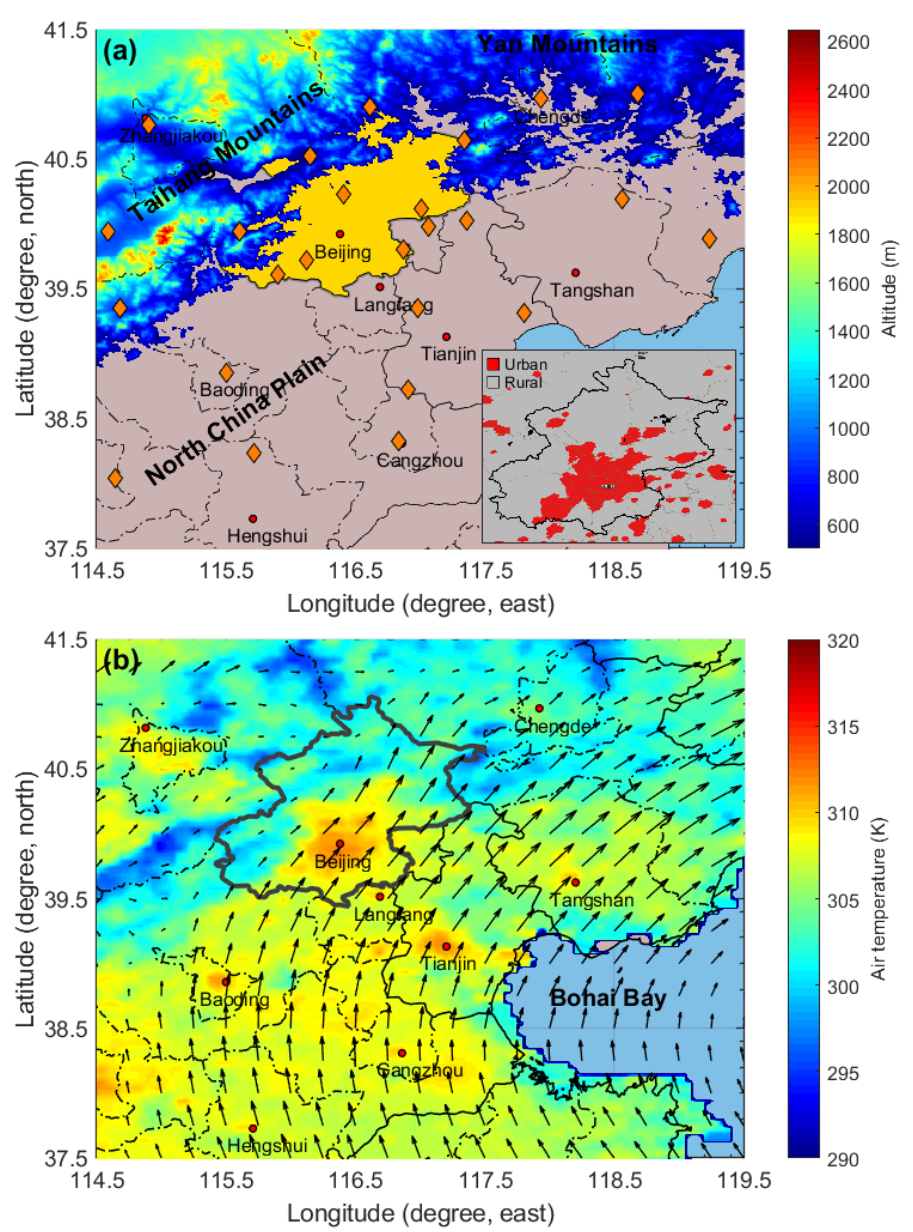
Figure 1. ( a ) Overview of the research area. Orange diamonds denote the site distribution of the National-Wide Lightning Detection Network operated by the State Grid Electric Power Research Institute. The inset shows the urban extent of Beijing provided by the United States National Aeronautics and Space Administration (NASA) (https://worldview.earthdata.nasa.gov/ accessed on 21 March 2021). ( b ) Geographical distribution of land-surface temperature and the low-altitude wind field at 925 hPa.